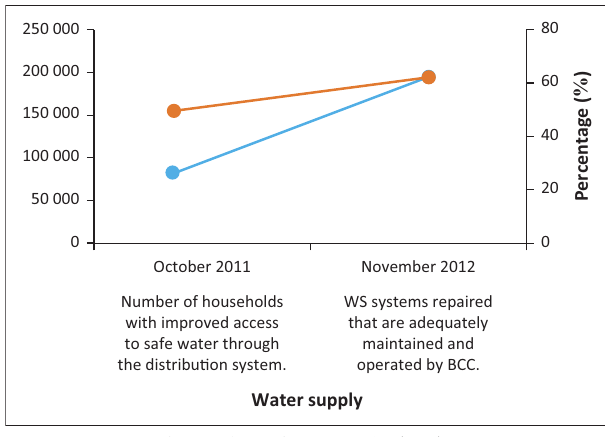
FIGURE 1: Improved water